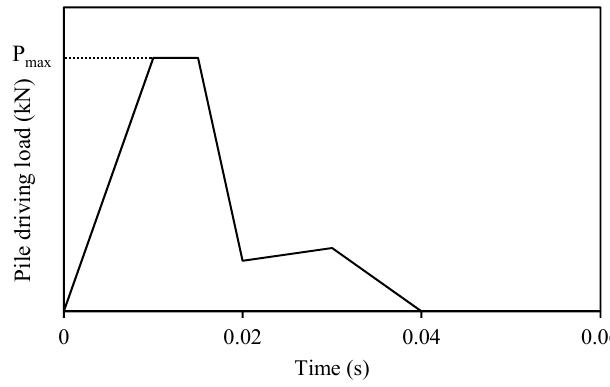
Figure 13. Pile driving load with time for one hammer blow (modified from Ko et al. [13]).